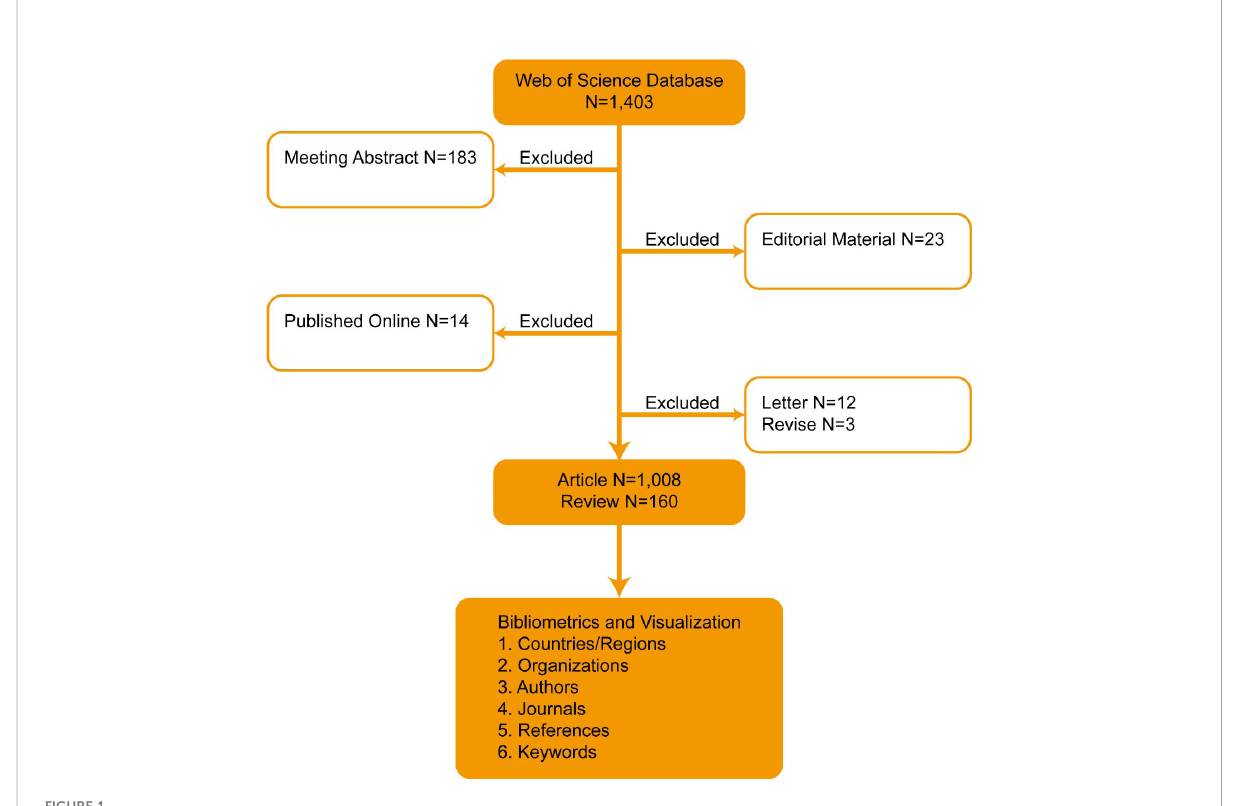
FIGURE 1 Search fl